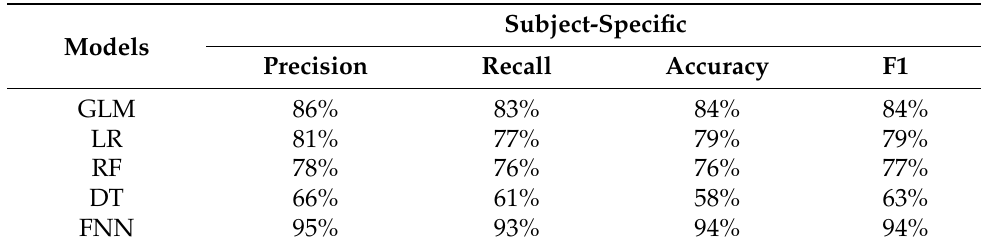
Table 6. Average precision, recall, and accuracy for subject-specific validations using the 16 extracted features to detect fatigue in biceps